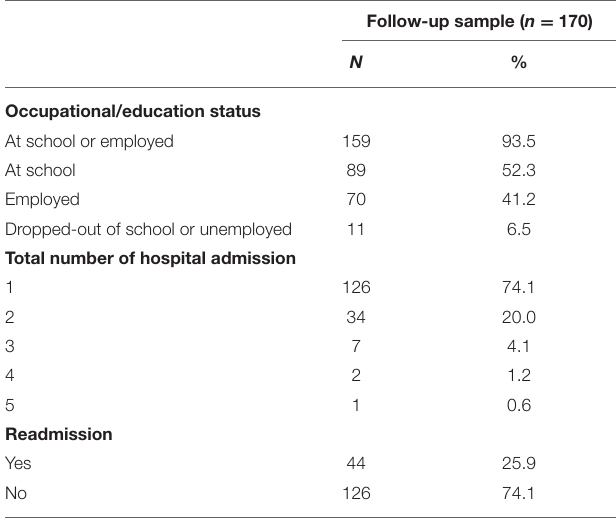
TABLE 4 | Outcomes of COS.